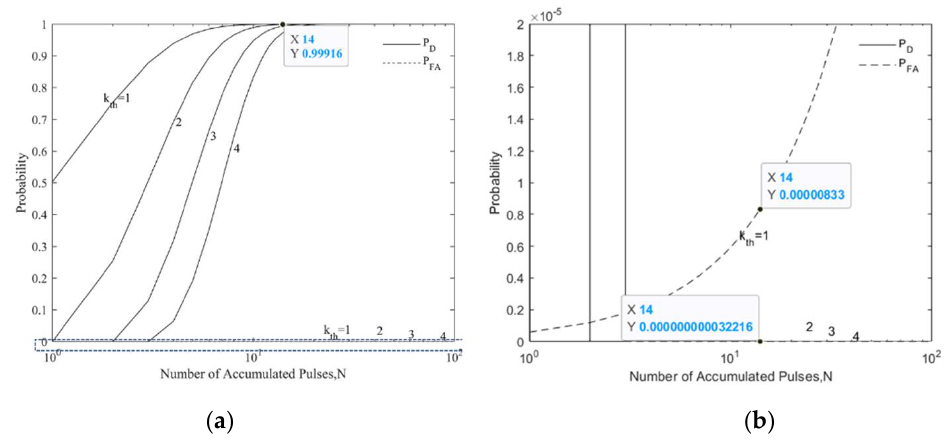
Figure 2. Detection probability and false-alarm probability: ( a ) influence of number of accumulated pulses on detection probability and false-alarm probability ( n s = 10, n n = 8.5 × 10 − 6 , k th = 1, 2, 3, 4) and ( b ) zoom in on the selected area, where the probability from 0 to 2 × 10 − 5 . Assuming the threshold is 1 in a time bin (10 ns), the received average number of noise photons n n is 8.5 × 10 − 6 , and the Quantum detection efficiency η qe is 7%. Figure 3 shows that the target detection probability will increase as the number of echo photons or the number of accumulated pulses increases, when the threshold and the average number of noise photons is fixed. The target false-alarm probability increases with the number of accumulated pulses increase, but the increase rate is low. Moreover, it has nothing to do with the number of signal photons. Therefore, we can appropriately increase the number of signal photons and the number of accumulated pulses to improve the target detection